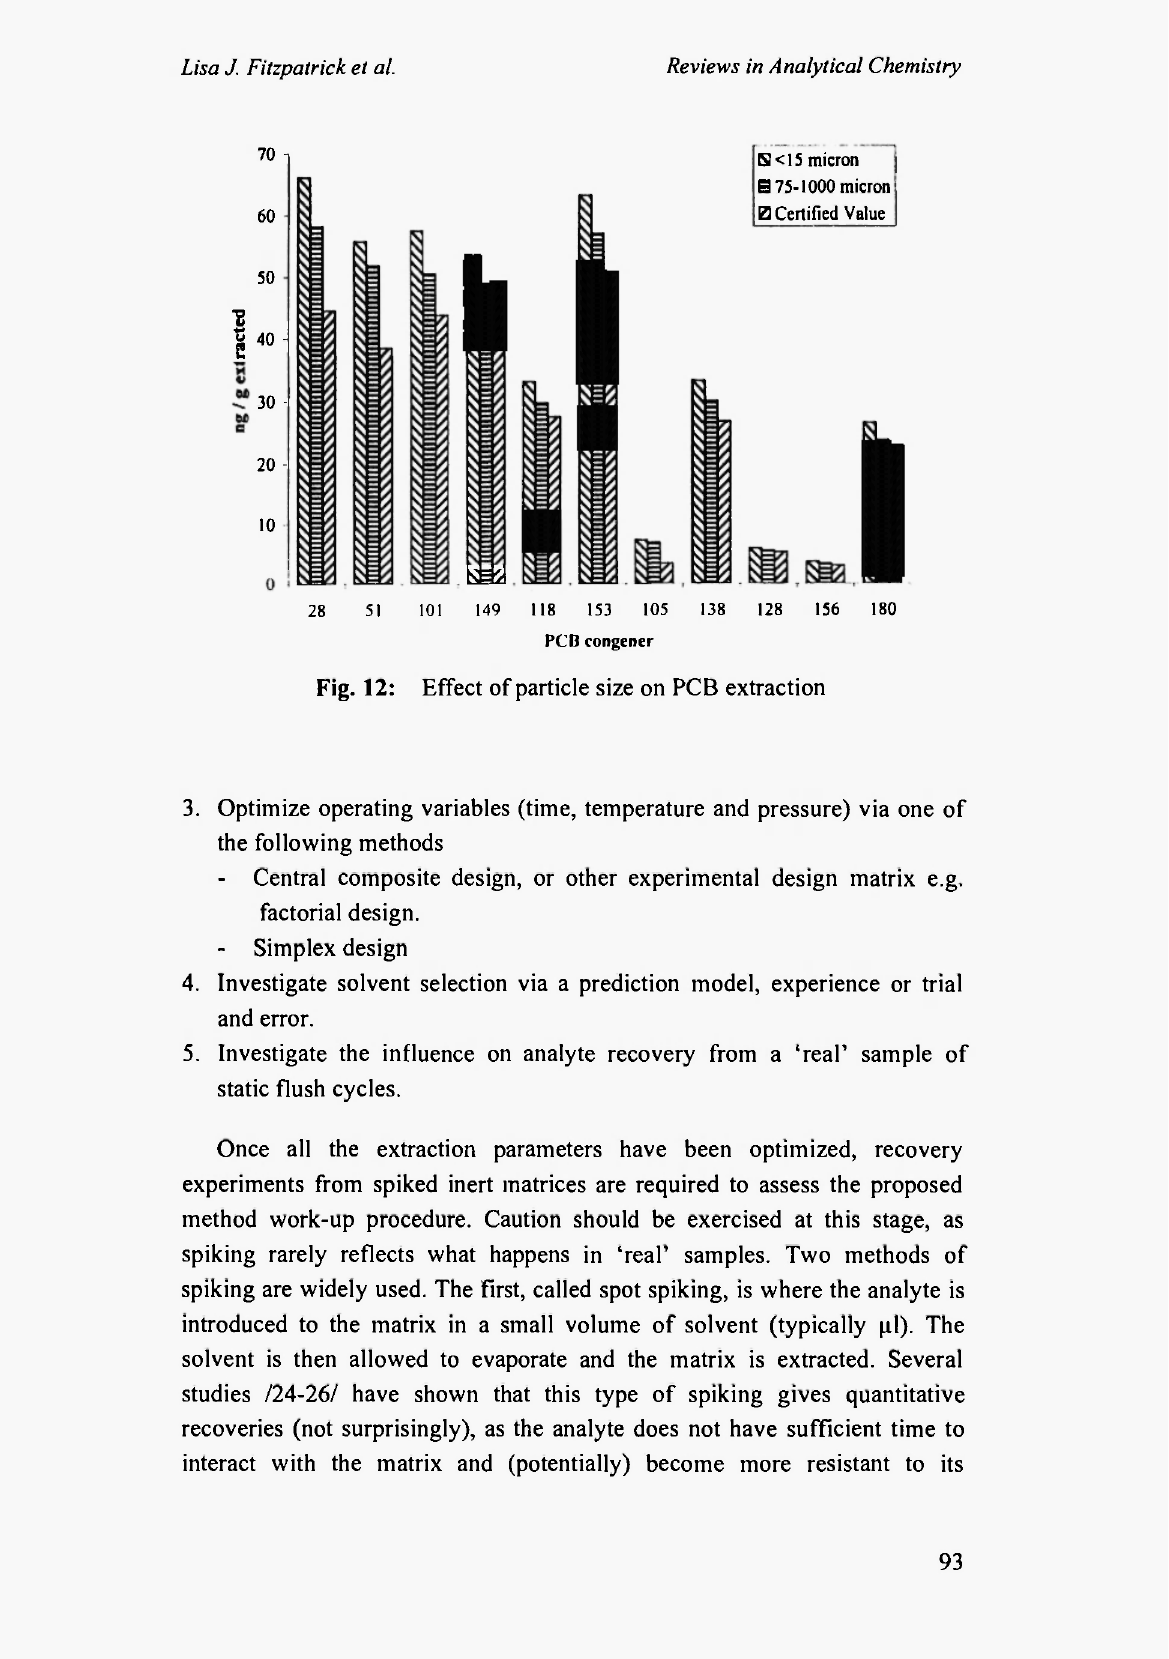
Fig. 12: Effect of particle size on PCB